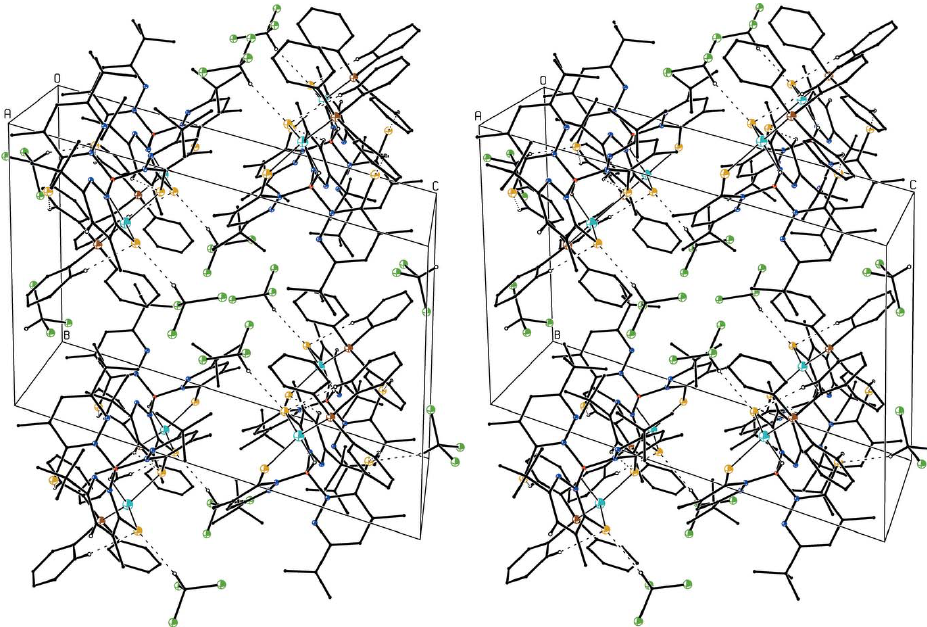
Figure 2 Stereoscopic plot of the packing of the title compound. The atoms are drawn with arbitrary radii. The non-classical C—H (cid:2)(cid:2)(cid:2) S interactions (Table 2) were plotted with dashed lines. H atoms not involved as well as the less occupied orientations of the disordered tert -butyl groups were omitted for